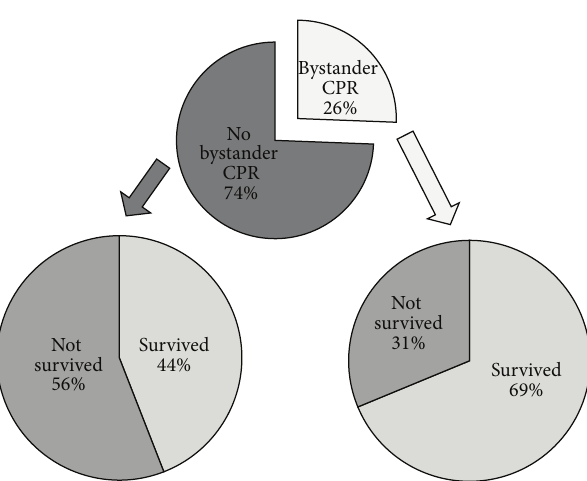
Figure 2: Effect of time delay in initiation of CPR on survival. Patients were evaluated based on time delay in CPR initiation. A trend line is displayed with an equation of 𝑦 = −0.05𝑥 + 0.77 and a coefficient of determination ( R -squared) of 0.7, indicating a favorable goodness of fit in correlation of the improved survival with reduced time delays in CPR initiation.